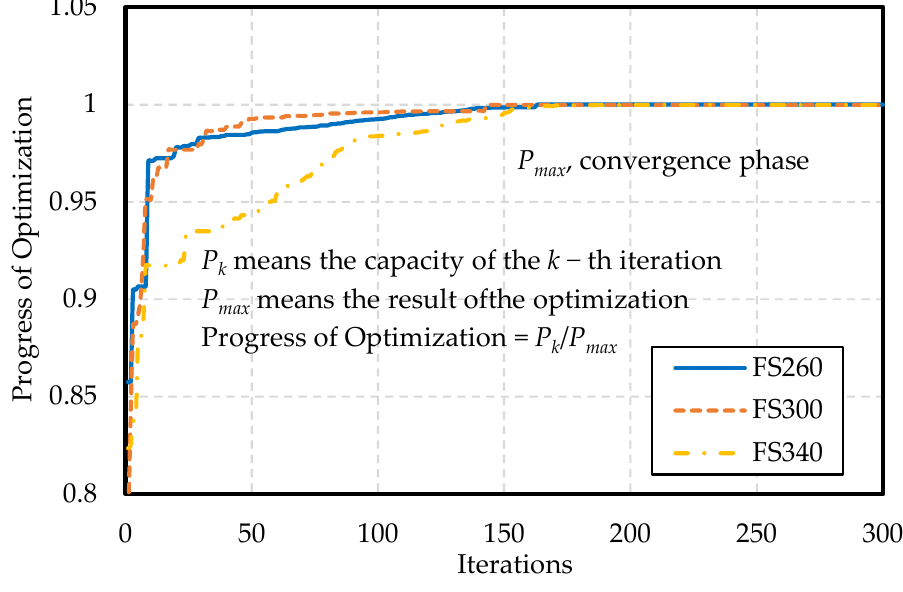
Figure 14. PSO history path.